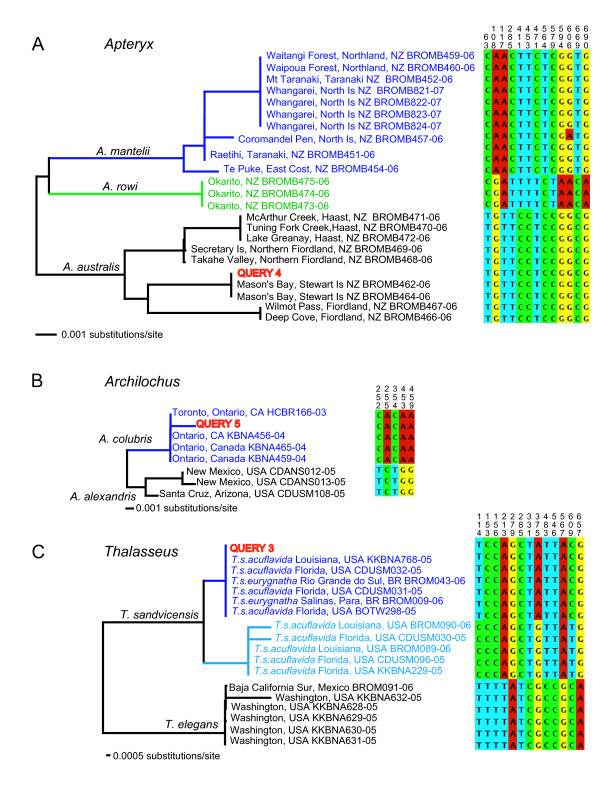
Assignment of unknowns. Neighbor-joining tree constructed with K2P genetic distances. Fixed substitutions are represented by coloured boxes, with corresponding character positions relative to the beginning of COI. Query specimens used in the test of assignment are indicated in red, with additional information in Table 2. a) Okarito Brown Kiwi (Apteryx rowi); b) Ruby-throated Hummingbird (Archilochus colubris); c) Sandwich Tern (Thalasseus sandvicensis).